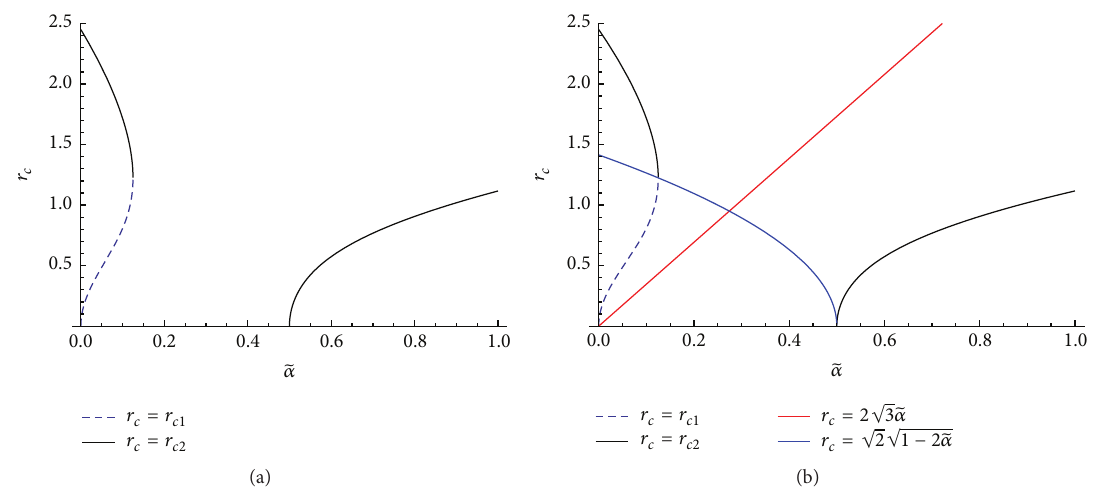
Figure 1: (a) 𝑟 𝑐 versus ̃𝛼 for 𝑘 = 1 , 𝑄 = 1 . (b) Curve constrained by positive Hawking temperature.